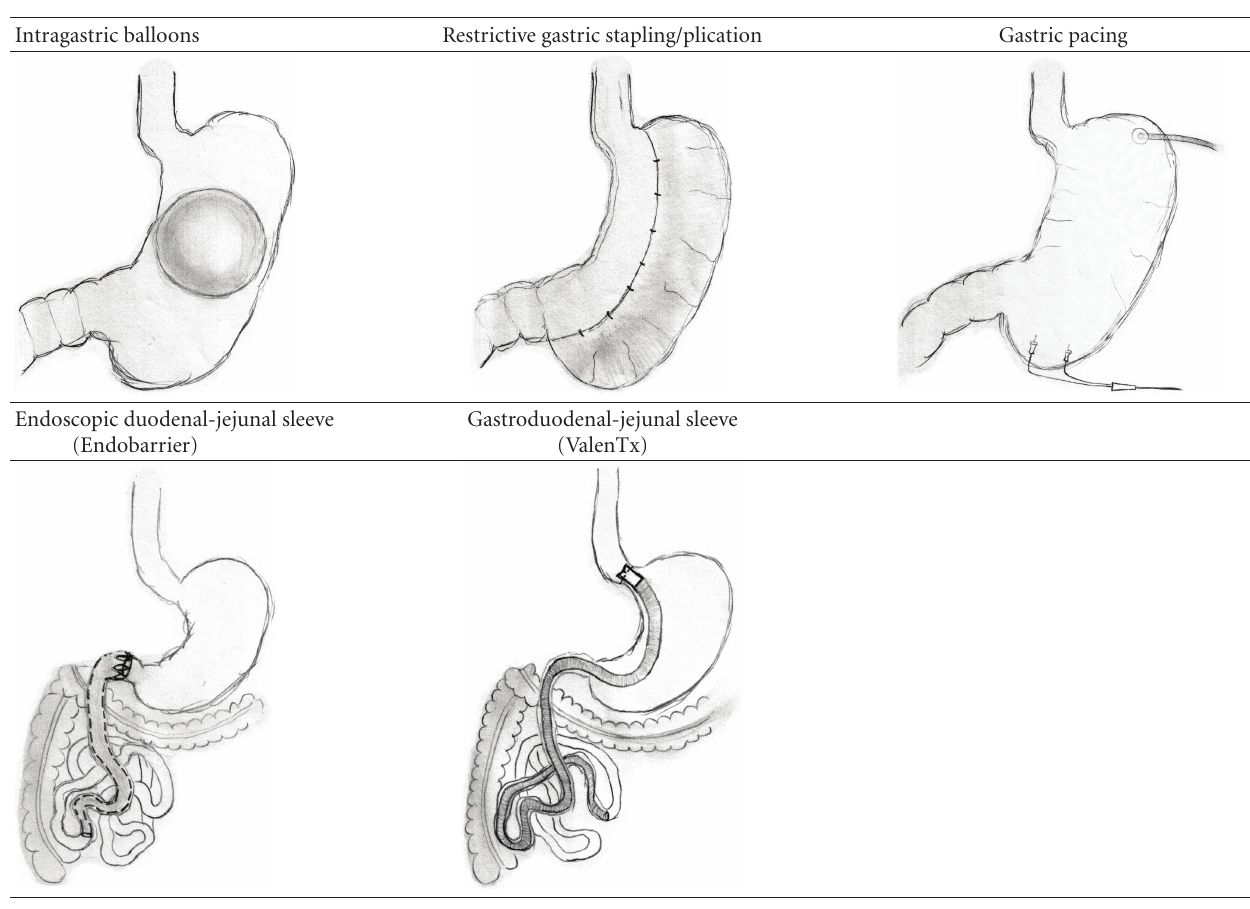
Table 2: Illustrations of methods mimicking bariatric